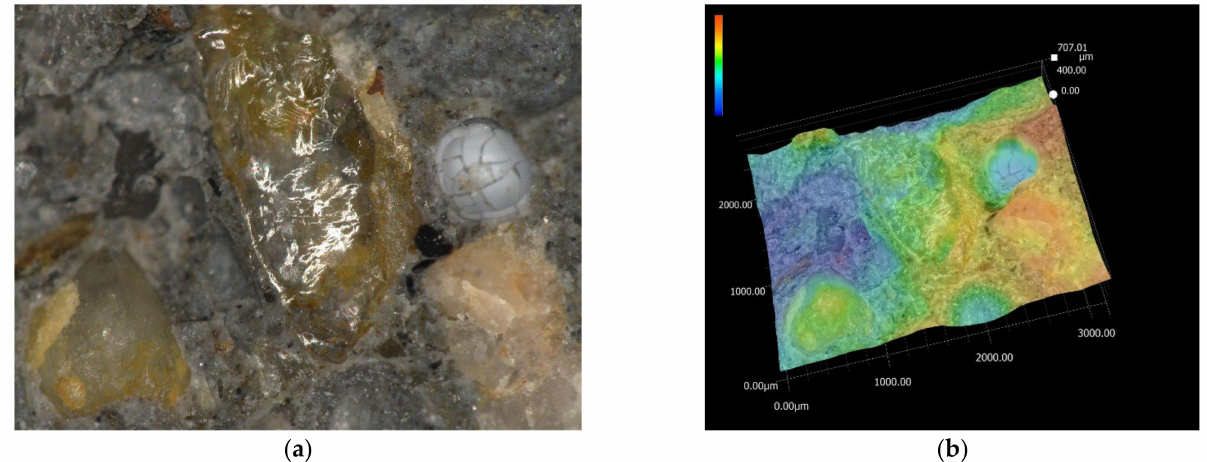
Figure 10. ( a ) Microstructure of 2000 × 3000 µ m; ( b ) fracture surface of 2000 × 3000 µ m: plain concrete (scale: bleu—min. 0; red—max. 707.01 µ